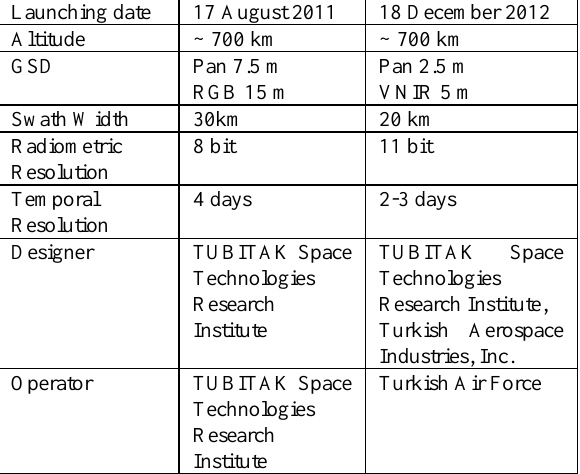
Table 1. Technical specifications of RASAT and GÖKTÜRK-2.